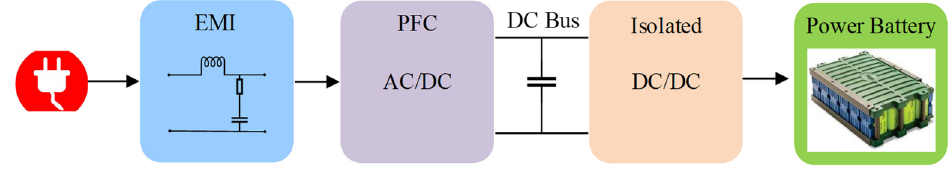
Figure 1. The two-stage architecture of a vehicle charger.